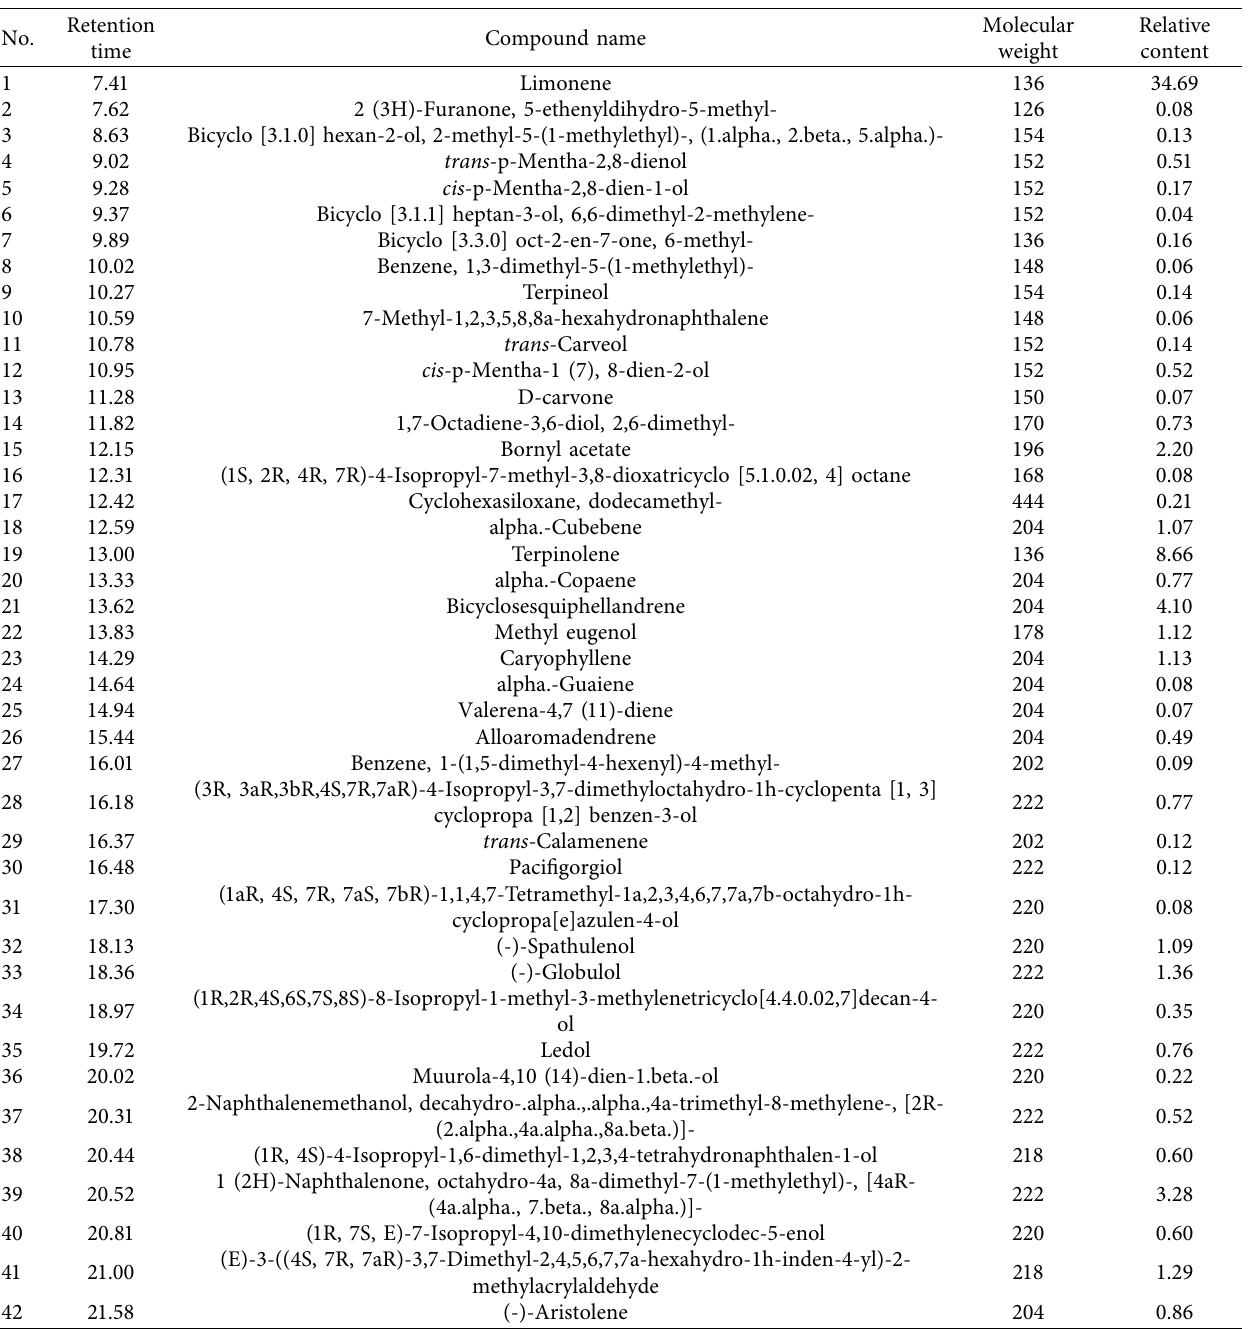
Table 3: Composition and relative contents of Plectranthus tomentosa